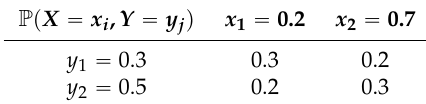
in Example X , Y “ p q